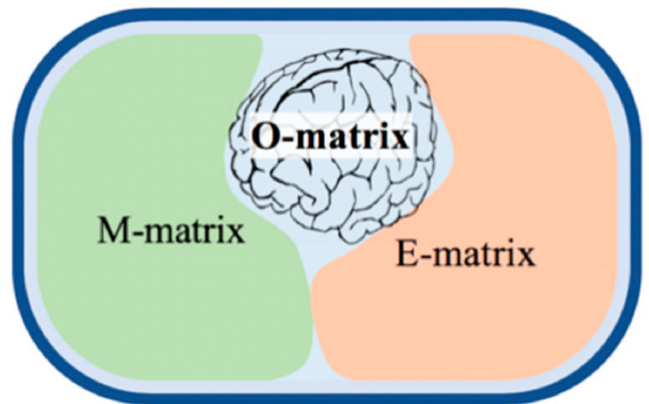
Figure 6. Simplified view on the bacterial genome structure through the prism of GEM